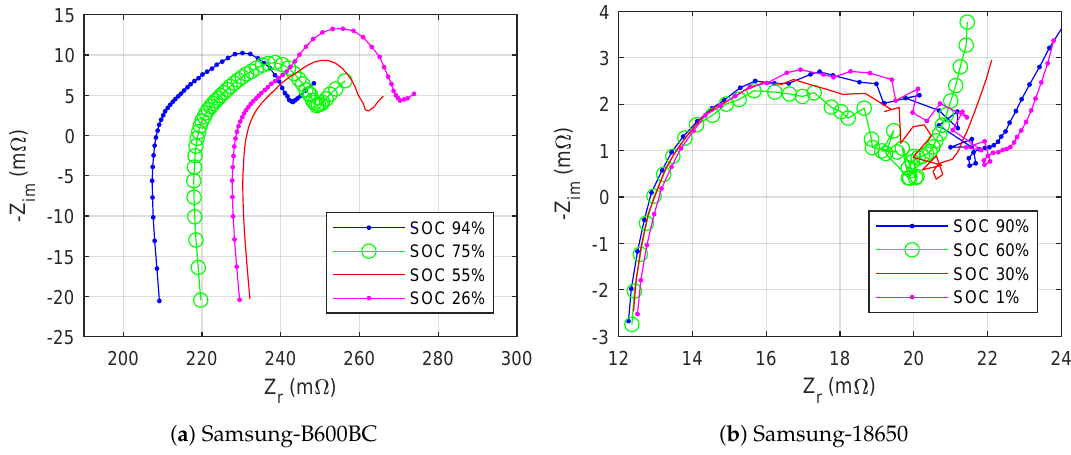
Figure 12. Impedance plots from EIS